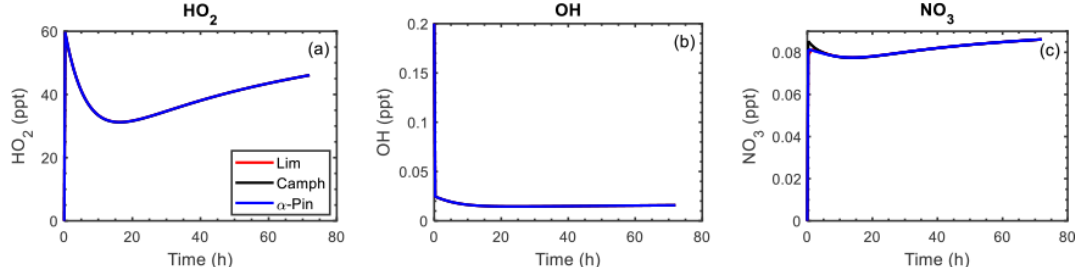
Figure 8. Mixing ratios of HO 2 , OH, and NO 3 as a function of time for limonene (red line), camphene (black line), and α -pinene (blue line) during the controlled reactivity simulations with 0.1ppb of HC o and 10µgm − 3 of organic seed. By design, the profiles of the mixing ratios for each precursor overlap except for at the very beginning of the NO 3 profile.